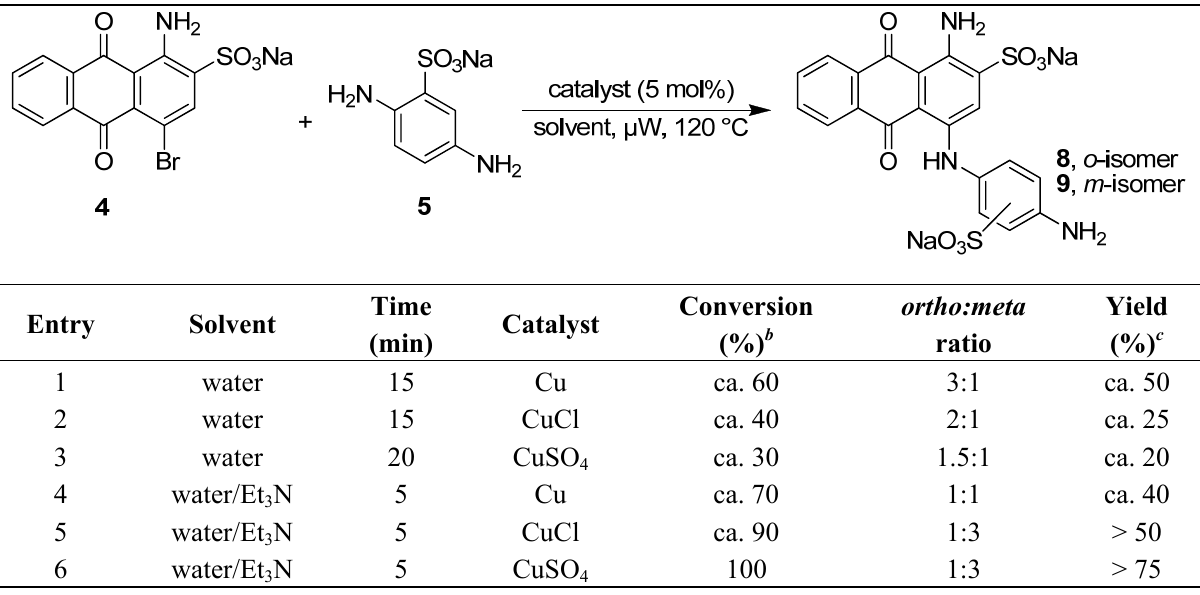
Table 3. Effects of different copper catalysts in the presence or absence of triethylamine (Et N) in aqueous medium on the synthesis of compounds 8 and 9 . 3